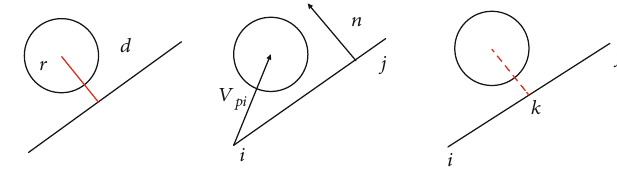
Figure 3: Point-edge contact